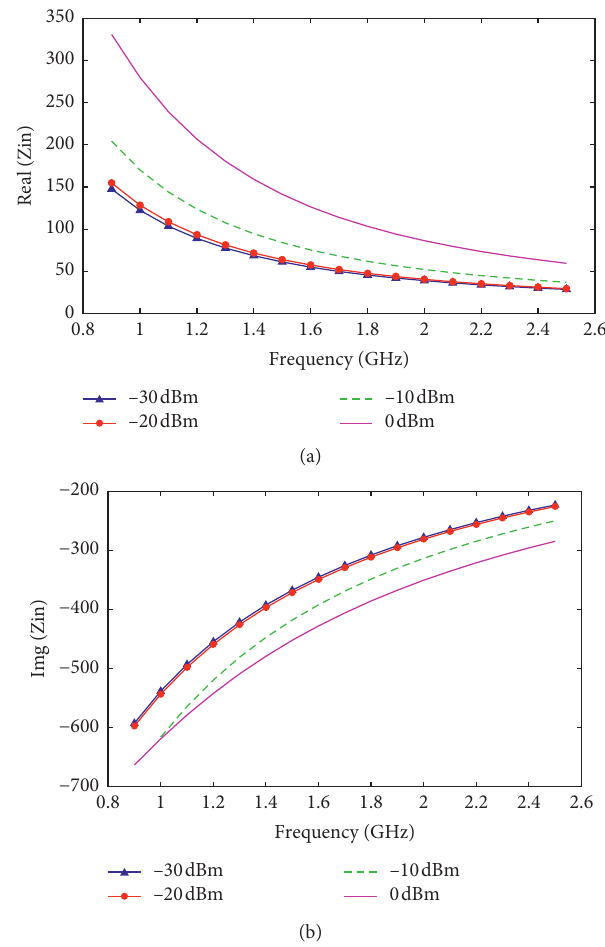
Figure 19: Input impedance of the voltage doubler rectifier versus frequency and input power levels for 10k Ω load. (a) Real part. (b) Imaginary